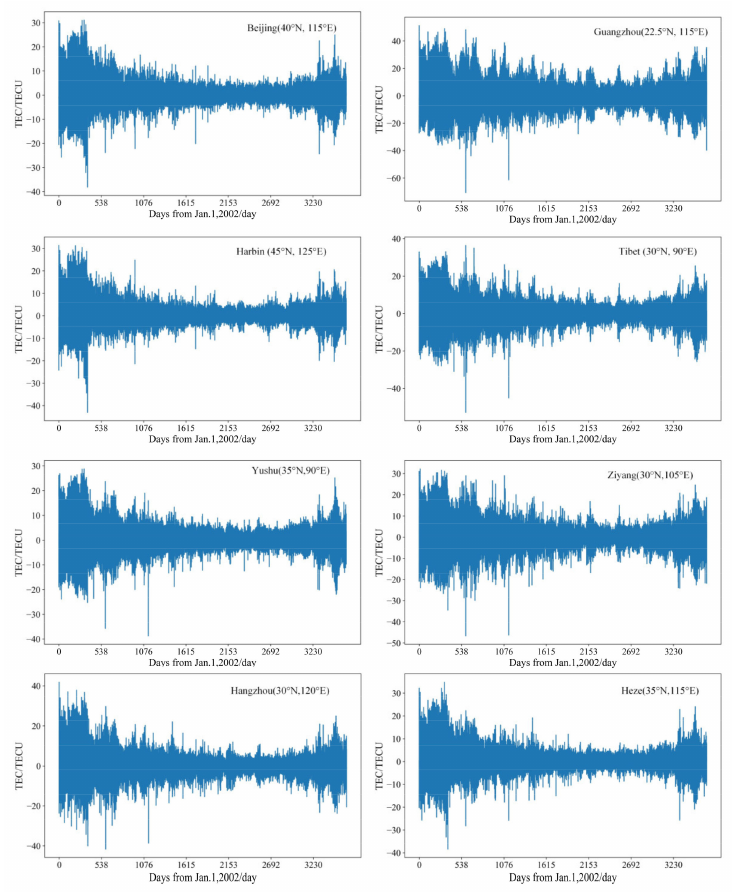
Figure 3. TEC values after first-order